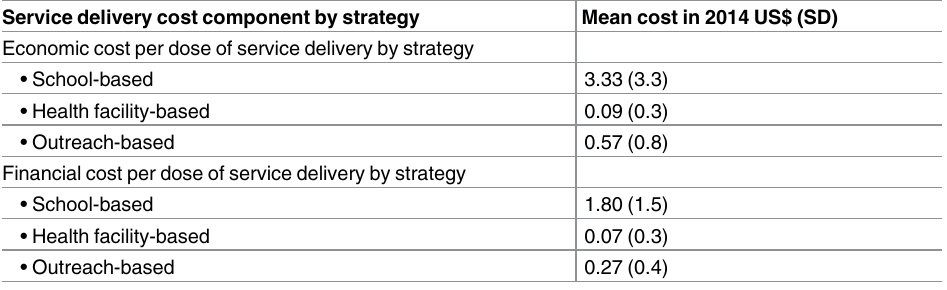
Table 6. Economic and financial costs per dose of servicedelivery cost component (2014